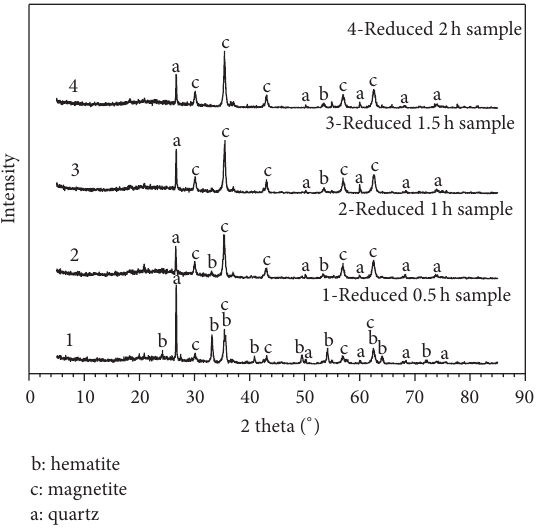
Figure 10: Grain size of the new-generation magnetite (Fe 3 O 4